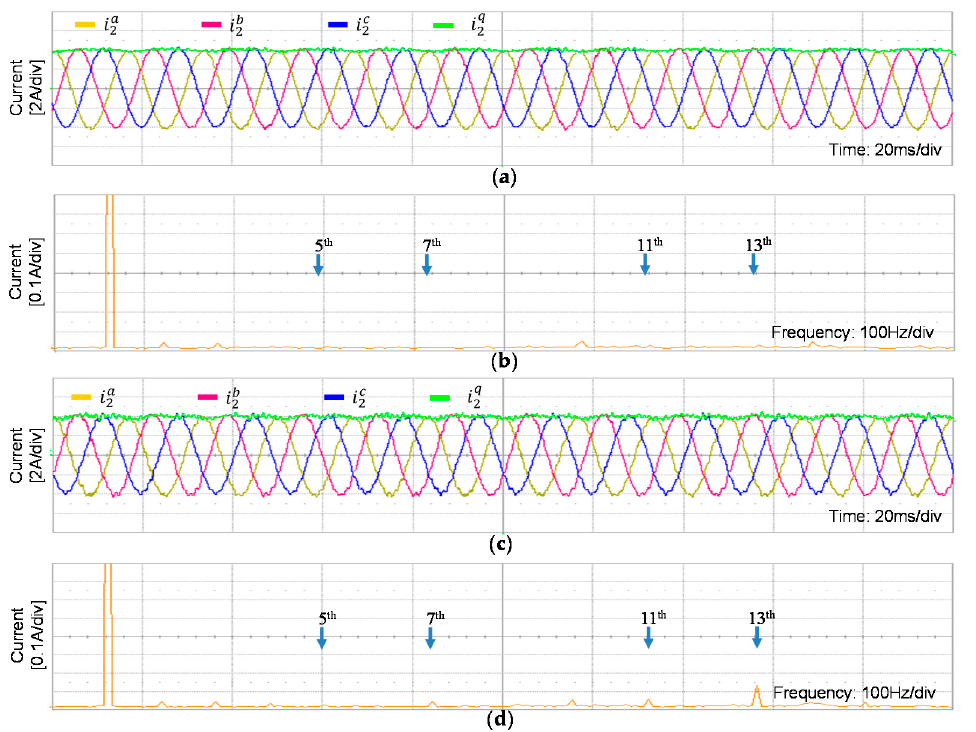
Figure 22. Experimental results of the proposed controller with L g = 1 mH. ( a ) Three-phase grid currents under distorted grid voltages; ( b ) FFT result of phase- a current under distorted grid voltages; ( c ) three-phase grid currents under distorted and imbalanced grid voltages with e a drop to 83.33% of the nominal value; and ( d ) FFT result of phase- a current under distorted and imbalanced grid voltages with e a drop to 83.33% of the nominal value.